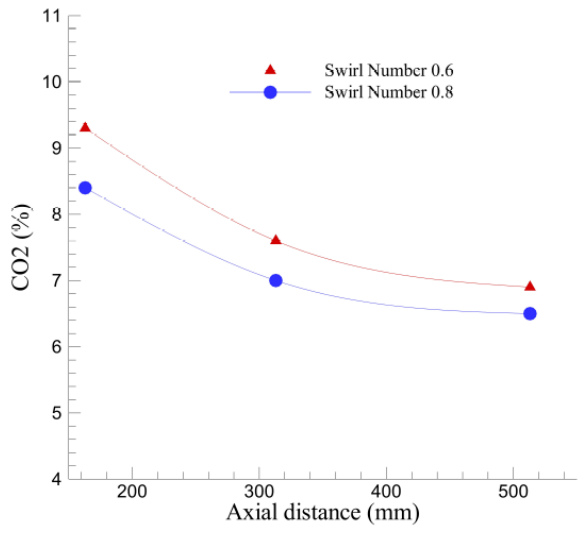
Figure 14: Axial CO emission profiles (Swirl number: 0.4, Equiva- lence ratio: